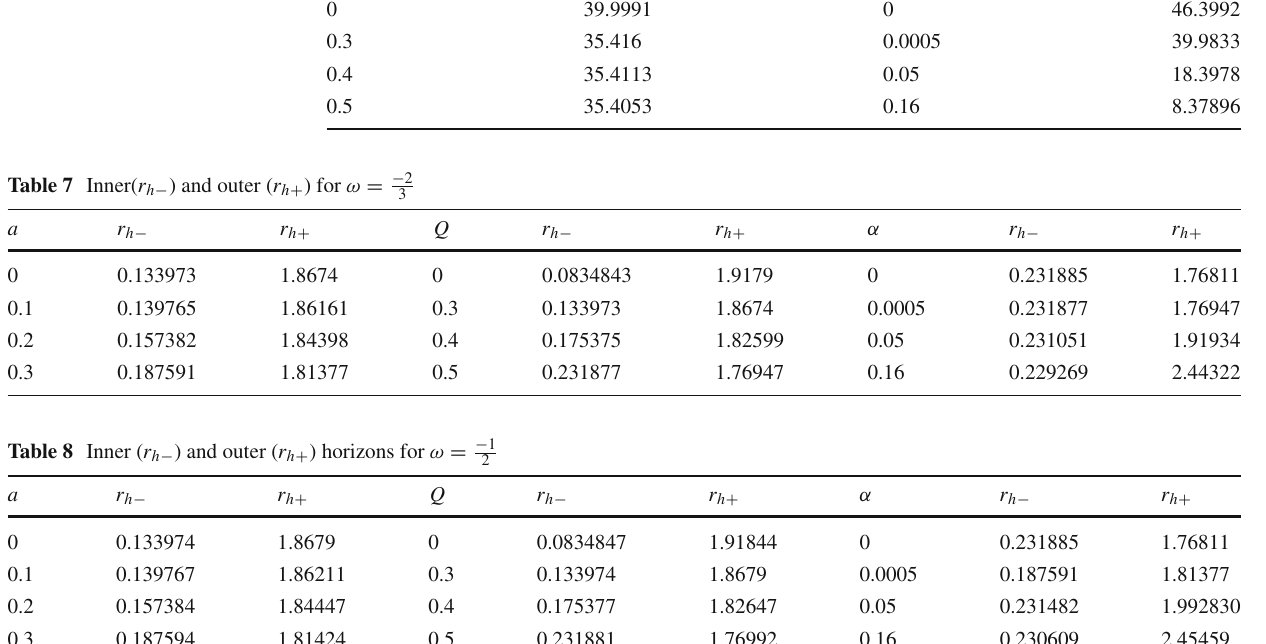
Table 9 Cosmological horizon r c for ω = − 2